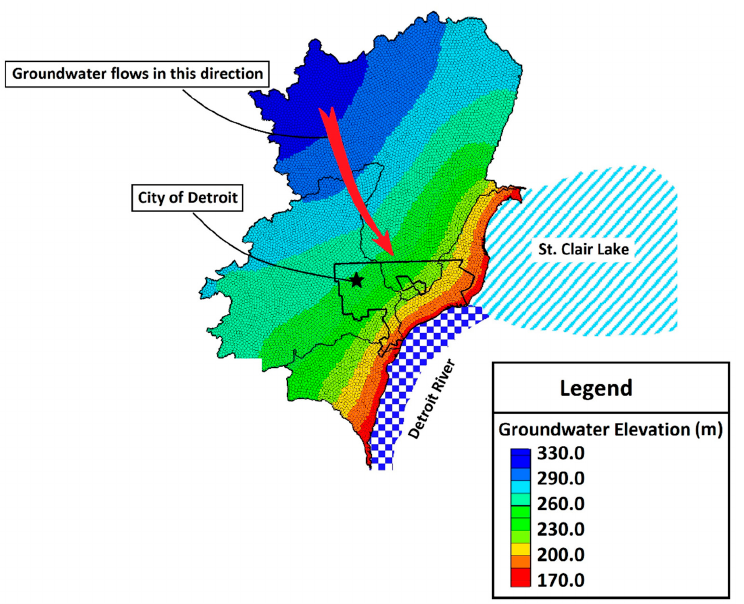
Figure 3. Regional flow features of shallow groundwater in Detroit. Flow rate is primarily towards the southeast.